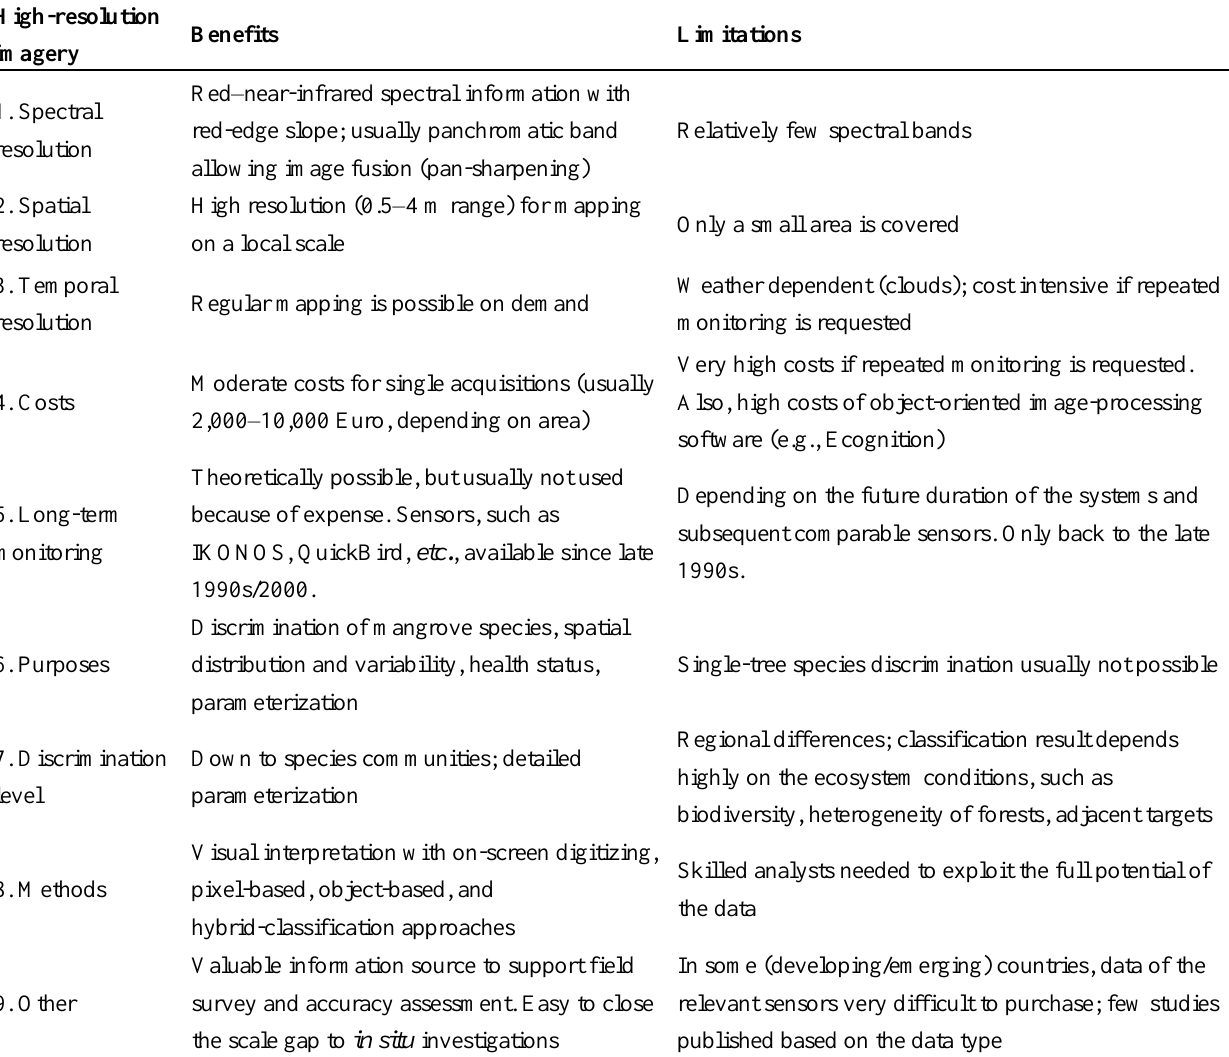
Table 5. Benefits and limitations of high-resolution imagery for mangrove